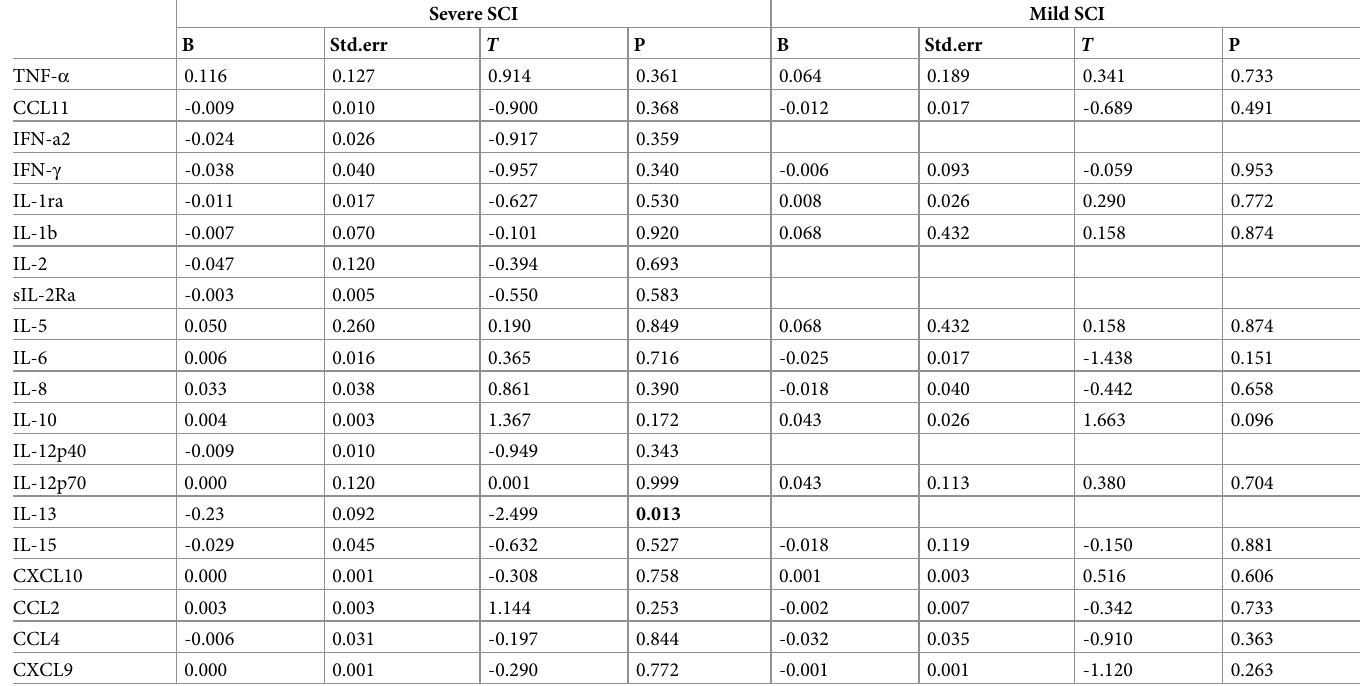
Table 5. Genetic effects on association of inflammatory mediators and pain scale.